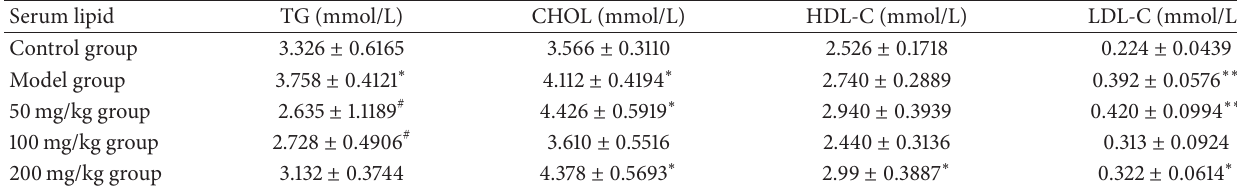
Table 6: Effects of BBE on serum lipid levels in STZ-diabetic